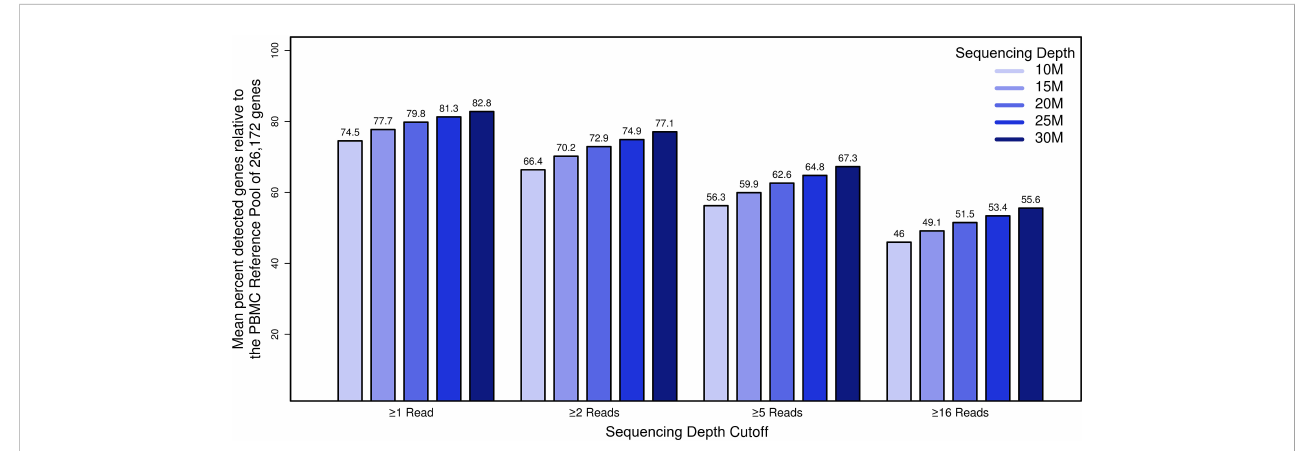
FIGURE 4 The impact of sequencing depth on gene representation by establishment of a deep “ compendium ” transcriptome of PBMCs. The x-axis represents simulated datasets (n=50) with coverage x, the y-axis shows the percentage of genes that we considered truly expressed in the PBMC compartment for genes that met the fi ltering cutoff. Bar plots summarizing the mean percentage of the detected PBMC compartment genes by coverage and read fi lter